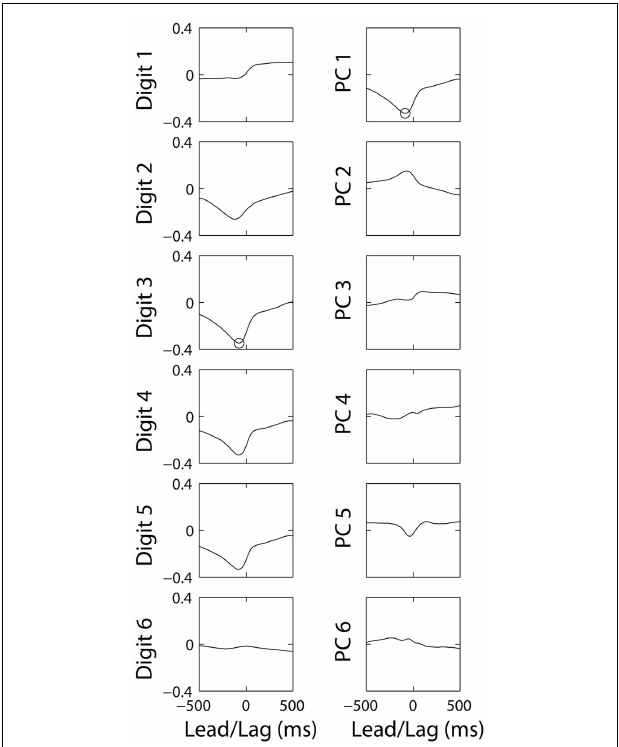
FIGURE 6 | Cross-correlations of the same M1 neuron’s firing rate with each original DoF and with each of the PCs from the same session .The correlation coefficient (ordinate) is plotted as a function of the lead or lag (abscissa). Negative times represent those at which discharge of the neuron led the kinematic variable. Circles indicate the maximal absolute cross correlation for this neuron with any of the digits (Digit 3) and with any of the PCs